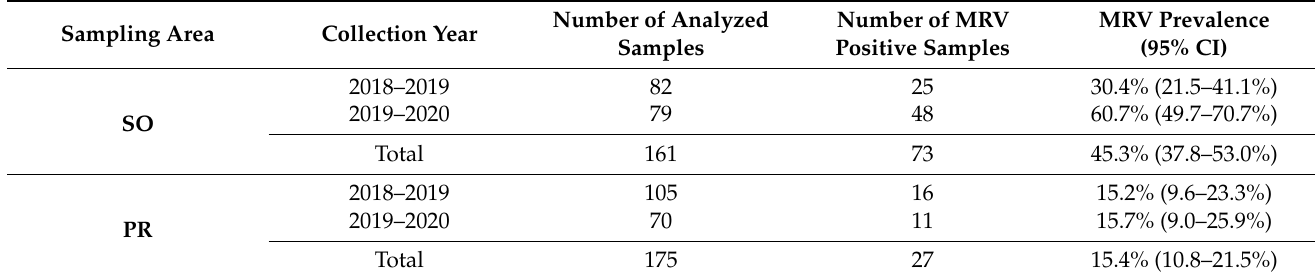
Table 7. Data between 2018 and 2020 hunting seasons in the two investigated areas (Sondrio–SO, and Parma–PR). In brackets 95%